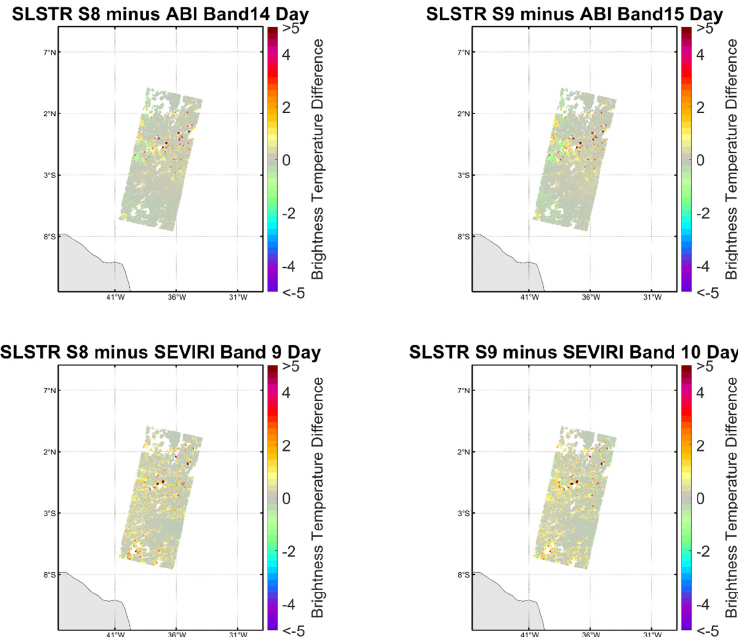
Figure 16. First row: distributions of the daytime BT difference between SLSTR and ABI in the cross-covered region on 27 November 2019, 12:09 UTC. The color indicates the SLSTR minus SEVIRI equivalent BT. Second row: corresponding BT difference distributions between SLSTR and SEVIRI.